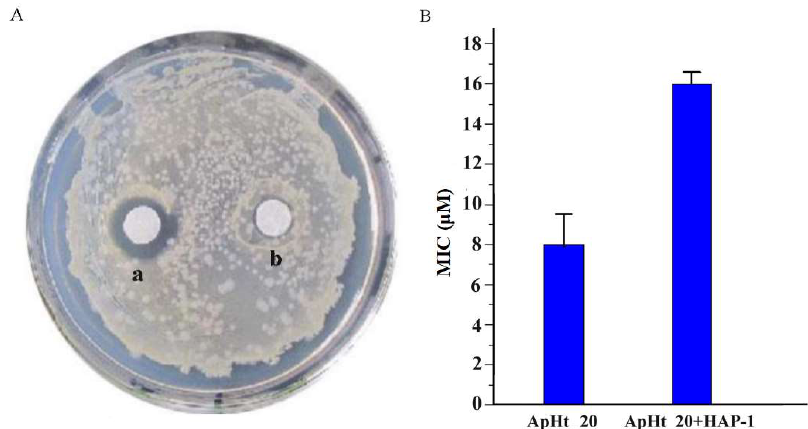
Figure 3. The inhibitory effect of HAP-1 on the antimicrobial activity of ApHt_20 (GFWGSLWEGVKSVI) against Staphylococcus aureus AB94004. ( A ) The agar diffusion assay. Disc a contains 40 nM of ApHt_20; Disc b contains 40 nM of ApHt_20 and 140 nM of HAP-1. ( B ) MICs of ApHt_20 against Staphylococcus aureus AB94004 in the presence /absence of 32 μM